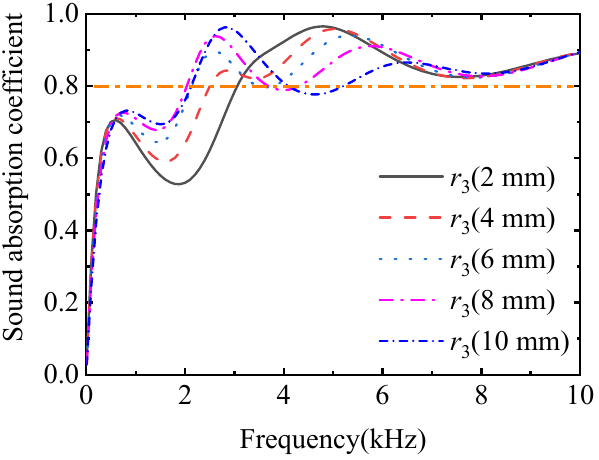
Figure 11. Comparison of α of SSC-CO corresponding to different cylinder radii.